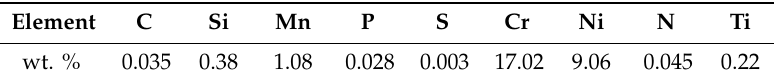
Table 1. Chemical composition of 321 austenitic stainless